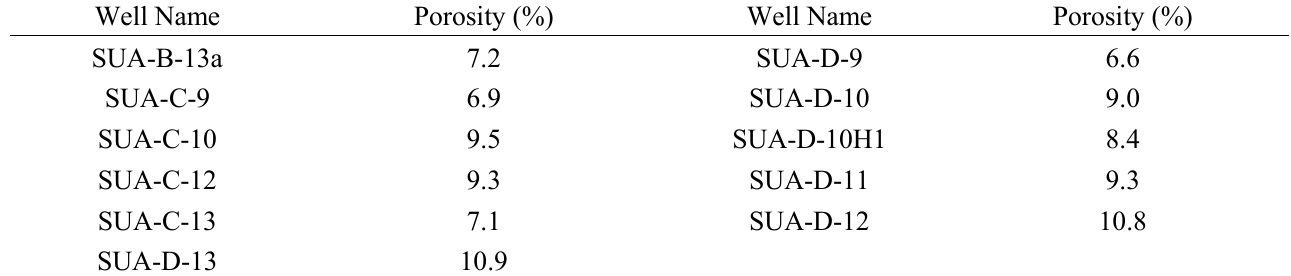
Table 2—Porosity statistics of SuA-B-CH2 adjacent wells.